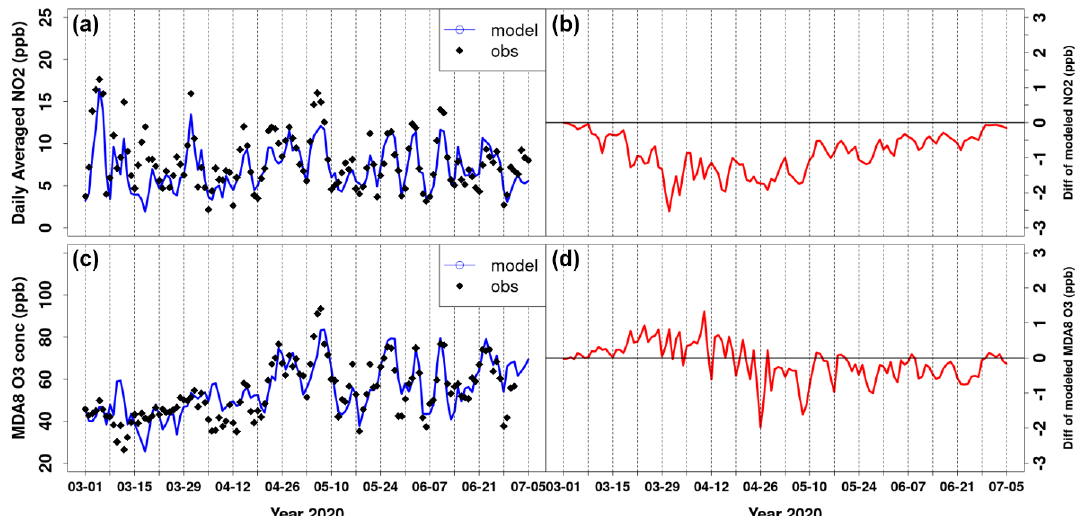
Figure 9. (a) Time series plots of daily averaged NO 2 concentrations in the South Coast Air Basin from simulations and observations. (b) Time series plots of the daily averaged NO 2 difference between the two sets of model simulations (model with the COVID-19-adjusted emission inventory minus the model with the baseline emission inventory). (c) Time series plots of averaged MDA8 O 3 concentrations in the South Coast Air Basin from simulations and observations. (d) Time series plots of the MDA8 O 3 difference between the two sets of model simulations (model with the COVID-19-adjusted emission inventory minus the model with the baseline emission